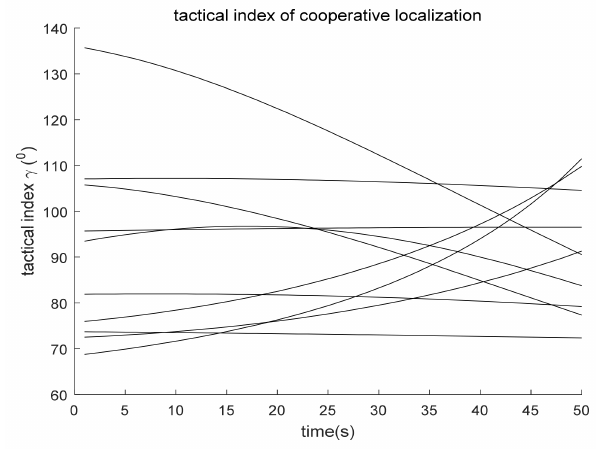
Figure 17. Intersection angle 2 γ between time difference localization platform and each point of the target